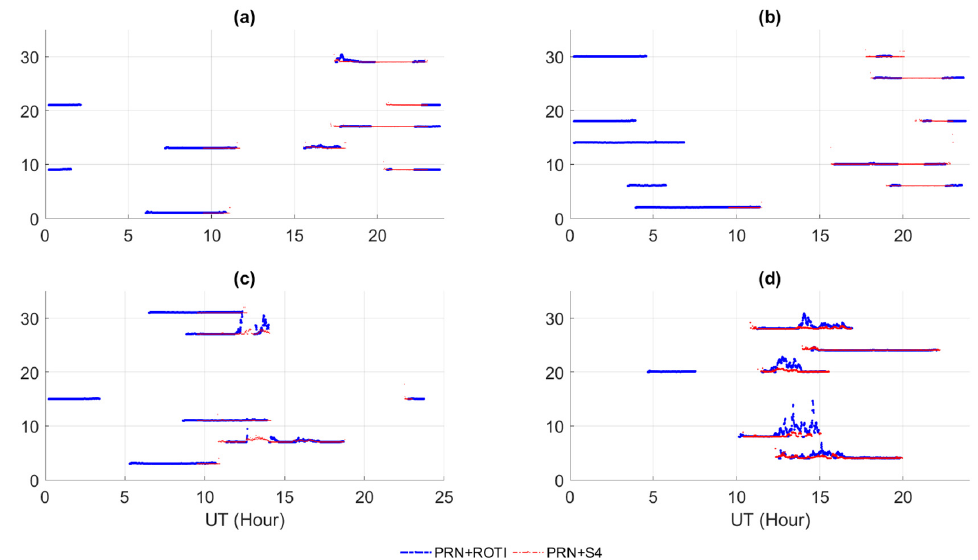
Figure 3. The time series of ROTI and amplitude scintillation index S 4 for all of the observed GPS satellites at the QION and FUKE sites (8 October 2003). The vertical axis is the sum of the ROTI or S 4 value and the PRN number of the corresponding satellite. The PRN numbers of each subfigure are as follows: ( a ) 1, 9, 13, 17, 21, 29; ( b ) 2, 6, 10, 14, 18, 26, 30; ( c ) 3, 7, 11, 15, 27, 31; ( d ) 4, 8, 20, 24, 28.